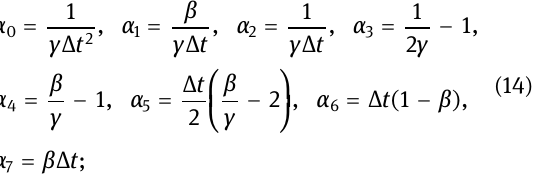
Figure 1: Multilayer framework simpli fi cation.